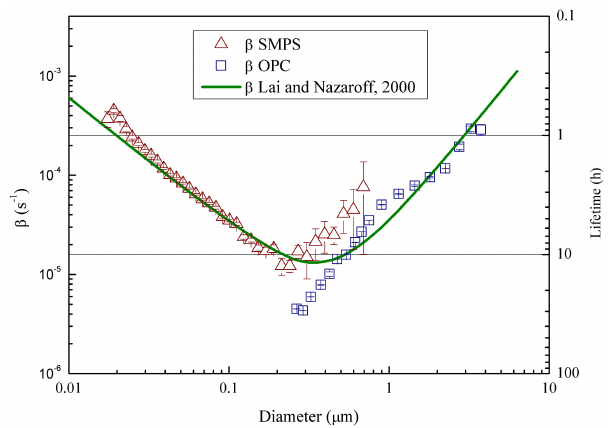
Figure 3. Particle loss coefficient ( β ) and lifetime (secondary ver- tical axis), vs. aerosol size measured in ChAMBRe by NaCl salt injection (21 ◦ C, 47%RH). The curve resulting from the Lai and Nazaroff (2000) model is also shown for reference (see text). Error bars include statistical uncertainties